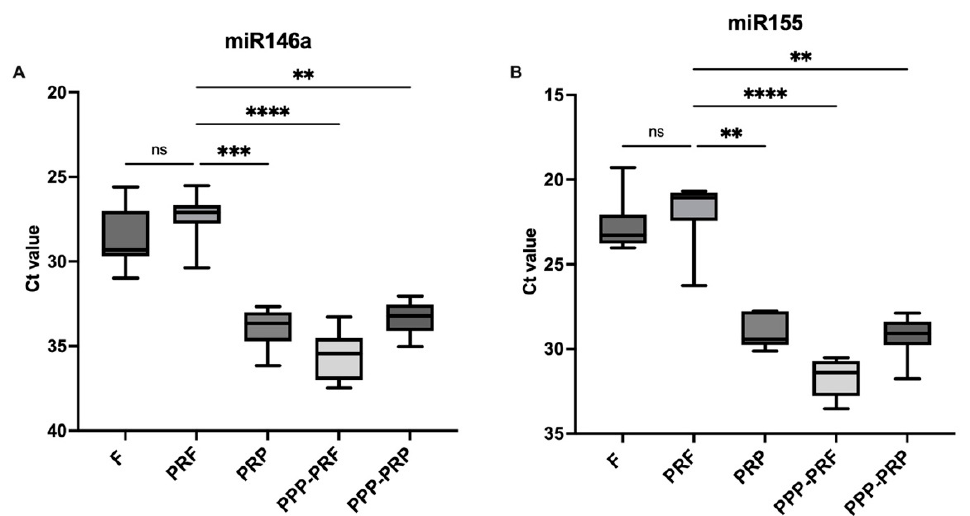
Figure 3. Comparison of Ct value levels of miR-146a ( A ) and mir-155 ( B ) in different autologous blood products of canine. qPCR analysis results are represented as Ct value. After the first collection day, total RNA was isolated from the samples and kept in − 30 ◦ C. PRF clot sample was separated into two substances: fibrin (PRF-F) and secretome (PRF-L), level of RNA in PRF-F was measured with a spectrophotometer. Significance is marked ** p < 0.01, *** p < 0.001, **** p < 0.0001, ns—non